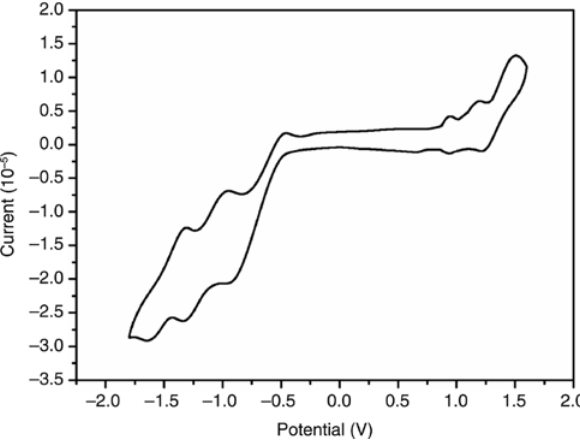
Figure 2: Cyclic voltammograms of 1.0 mm of spirosilole 1 in CH Cl with 0.1 m tetrabutylammonium perchlorate as supporting 2 2